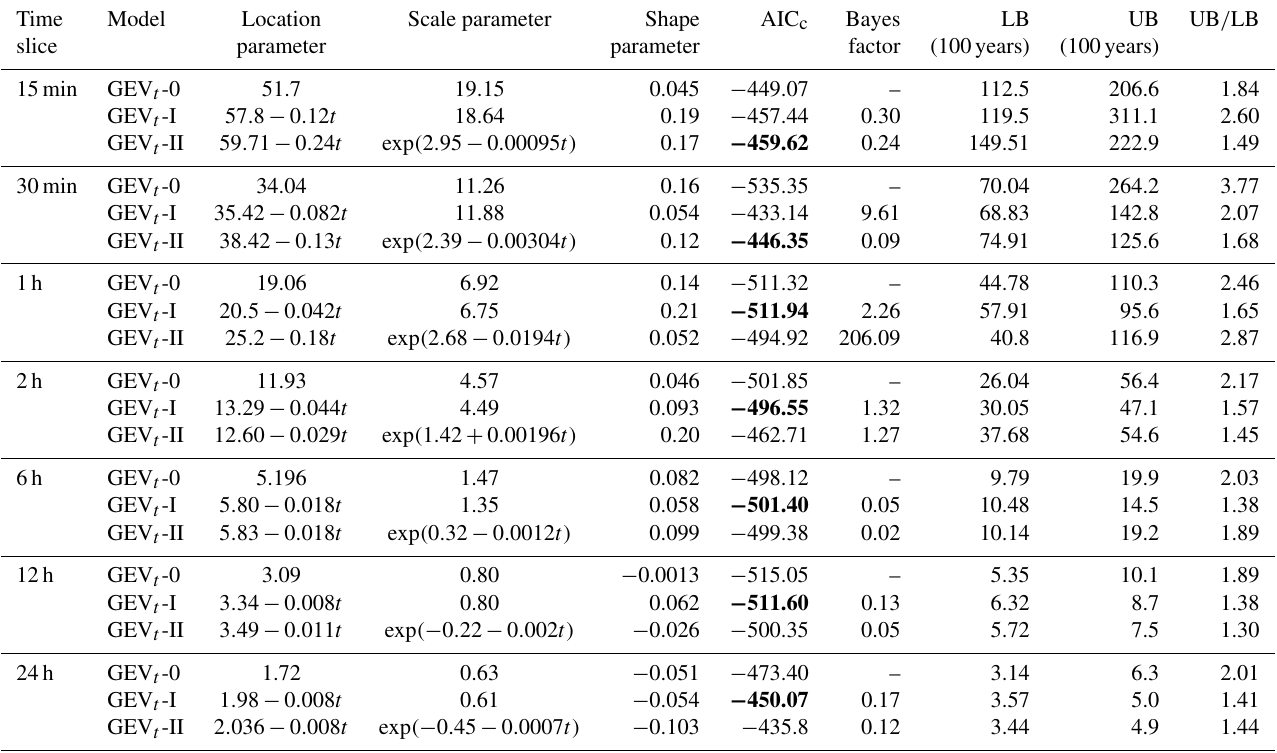
Table 5. Performance of stationary and nonstationary models for London International Airport. Time Model